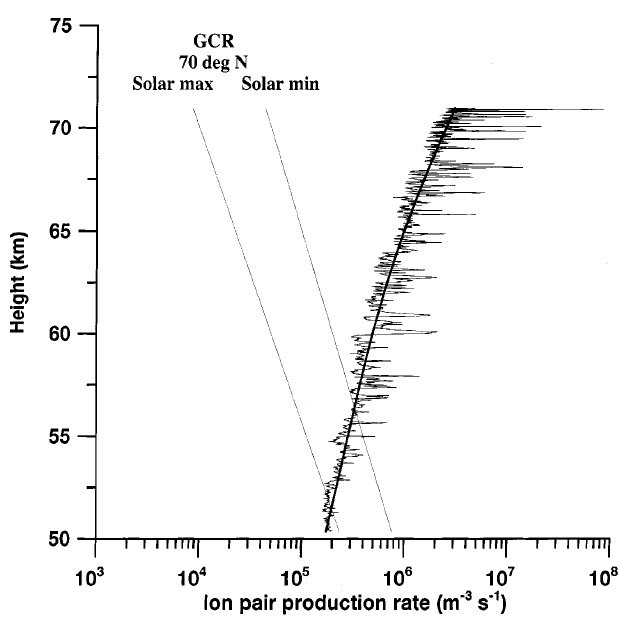
Fig. 8. The derived ion production rate q ( h ) for the slowly varying background and the peaks. The figure also shows the ion production rate expected from galactic cosmic rays (GCR) at 70 (cid:176) N and for solar maximum and minimum conditions